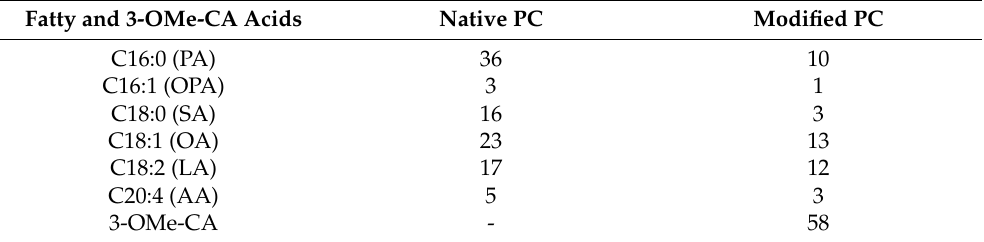
Table 3. Composition of fatty acids (mol%) of native egg-yolk PC and modified PC. Fatty and 3-OMe-CA